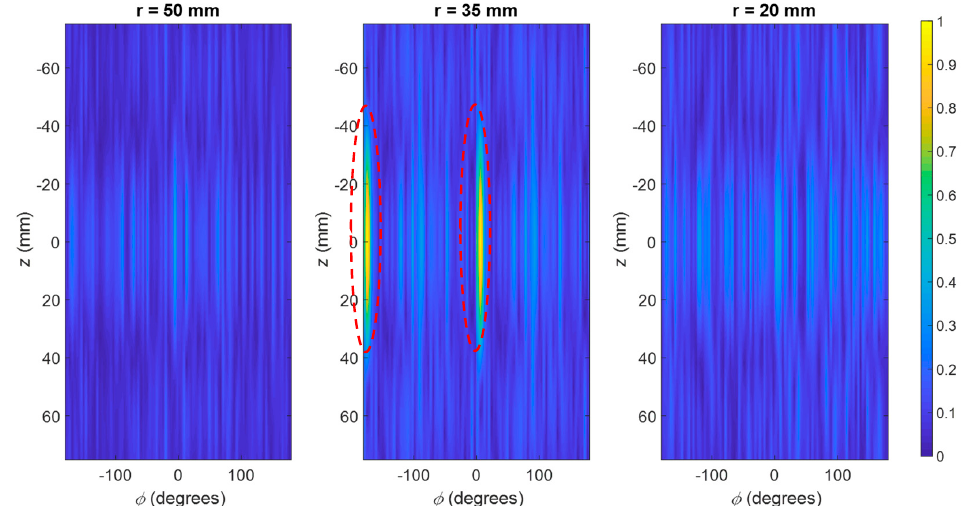
Figure 18. Normalized 3D reconstructed image of the objects on the middle surface for three imaged surfaces at radii of 50, 35, and 20 mm using double frequency data collected by eight receiver antennas. The red dashed lines show the reconstructed objects.